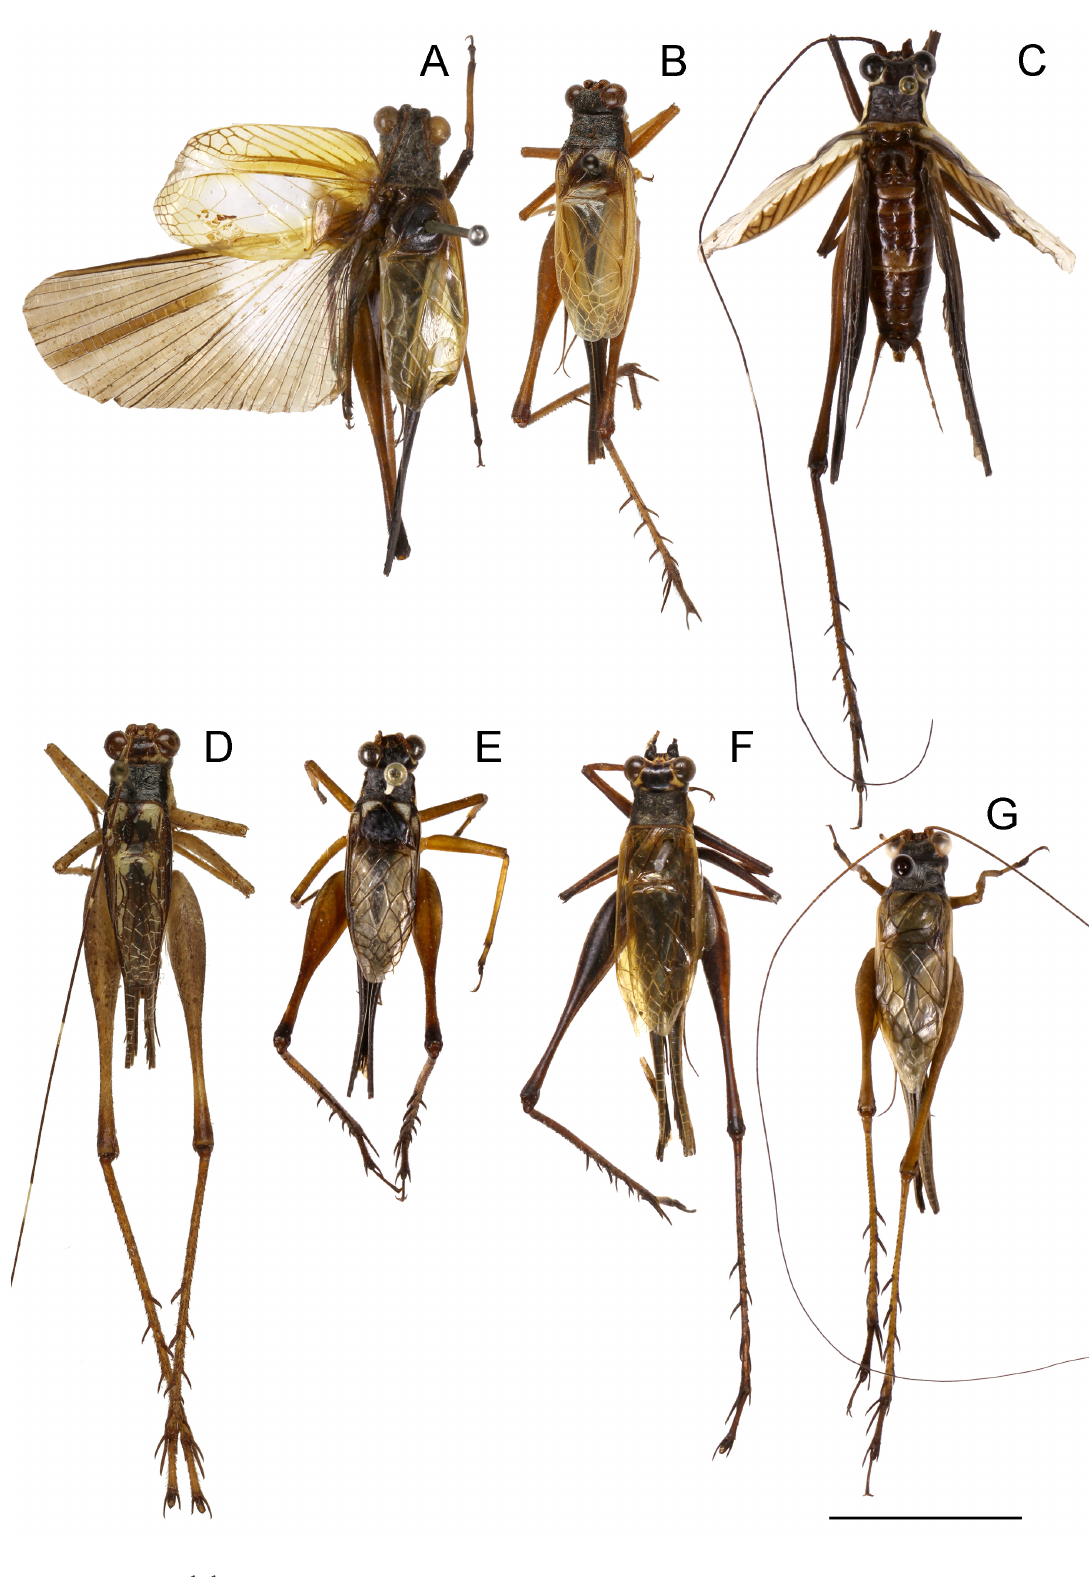
Fig. 7. Habitus of ♂♂ in dorsal view. A . Nisitrus brunnerianus Saussure, 1878. B . N. crucius Robillard